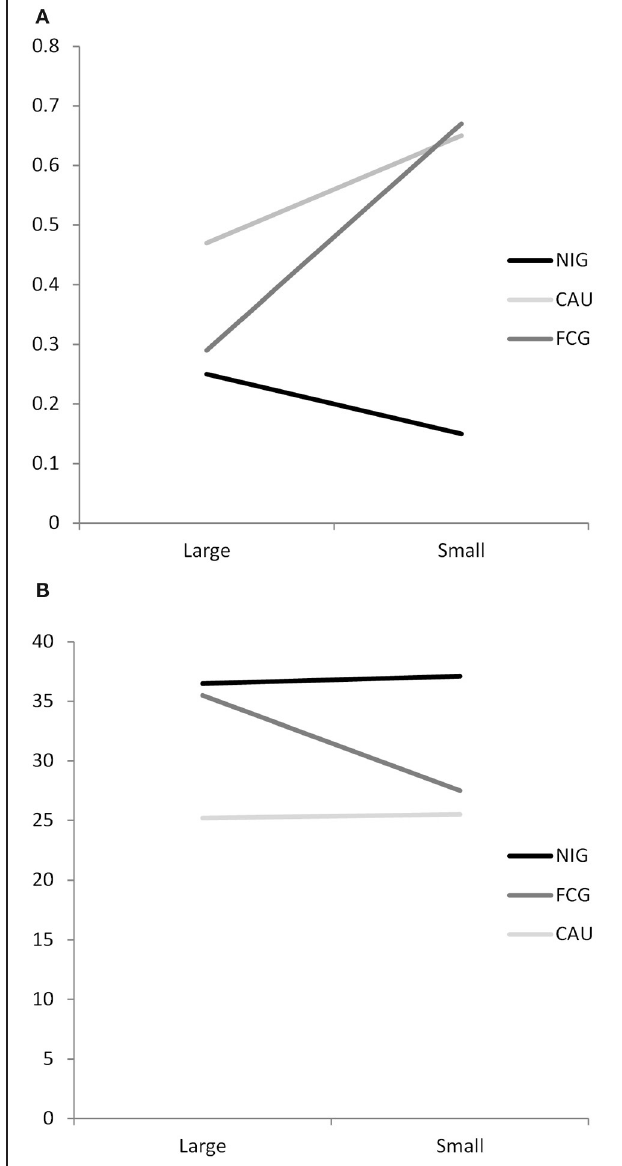
FIGURE 3 | Moderation analyses of Group × ERN for (A) externalizing-ADHD behaviors as measured by the HBQ (B) academic competence as measured by the